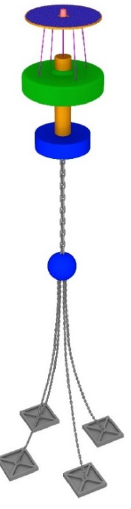
Figure 2. Point absorber device.